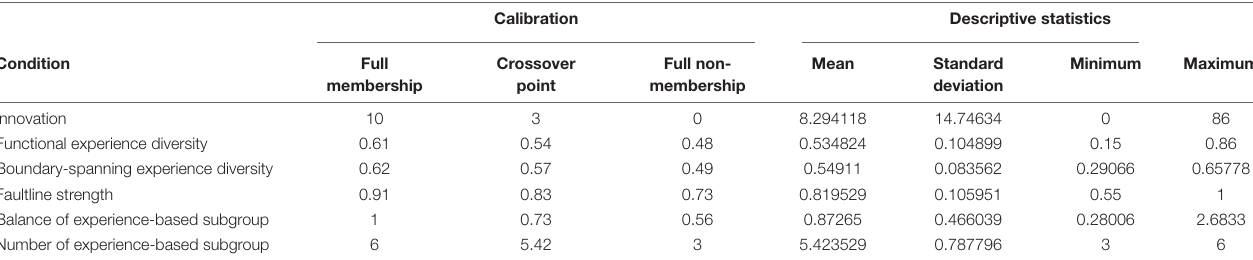
TABLE 1 | The calibration and descriptive statistics.